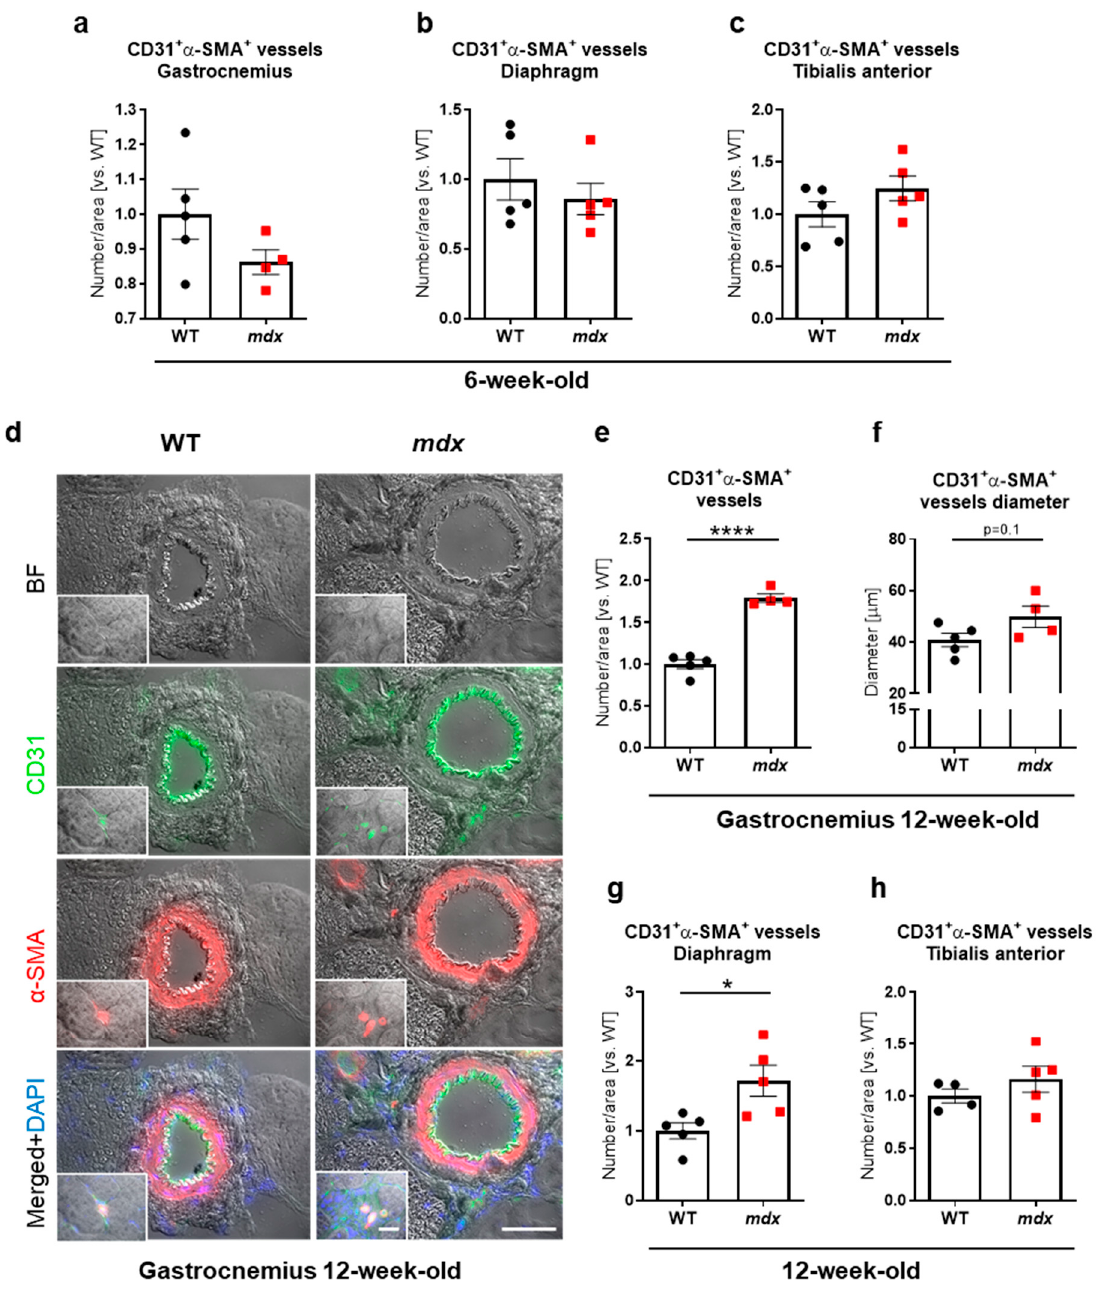
Figure 2. Blood vessel abundance in skeletal muscles of 6- and 12-week-old WT and mdx mice. In 6-week-old animals, the abundance of CD31+ α -SMA+ double-positive vessels was not changed in the dystrophic ( a ) gastrocnemius, ( b ) diaphragm, and ( c ) tibialis anterior; quantitative analysis based on immunofluorescent staining; n = 4–5/group. ( d ) Representative pictures from immunofluorescent staining of CD31 + α -SMA + double-positive blood vessels in the gastrocnemius muscle of 12-week-old mice together with quantification indicating ( e ) elevated number of CD31 + α -SMA + double-positive blood vessels and ( f ) a tendency for increased blood vessel diameter in dystrophic mice. The number of CD31 + α -SMA + double- positive vessels assessed in ( g ) the diaphragm and ( h ) tibialis anterior of 12-week-old animals. Scale bar: 10 μ m; bright field (BF). The results are presented as mean ± SEM. * p < 0.05, **** p < 0.0001 with unpaired two-tailed Student’s t -test.